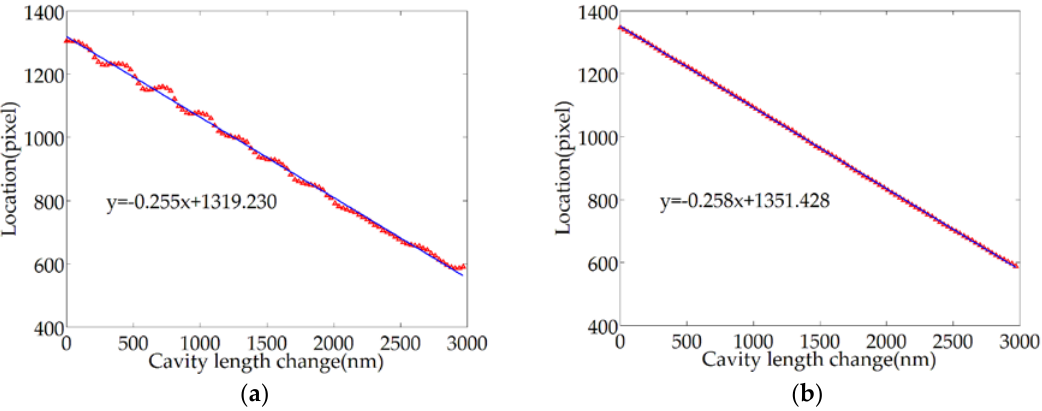
Figure 14. Characteristic curves of sample points: ( a ) the curve of envelope center-cavity length obtained by wavelet processing; ( b ) the curve of middle location-cavity length obtained by the algorithm in this paper.